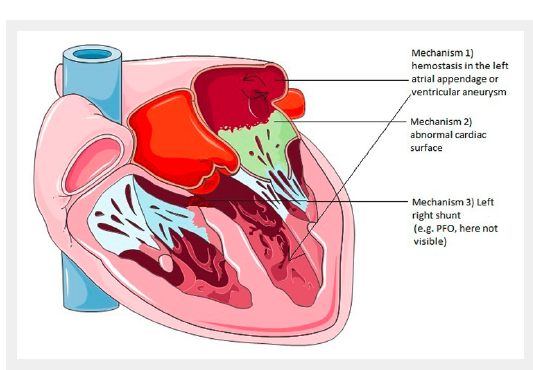
Examples of stroke aetiologies (imaging material adapted from Servier Medical Art).